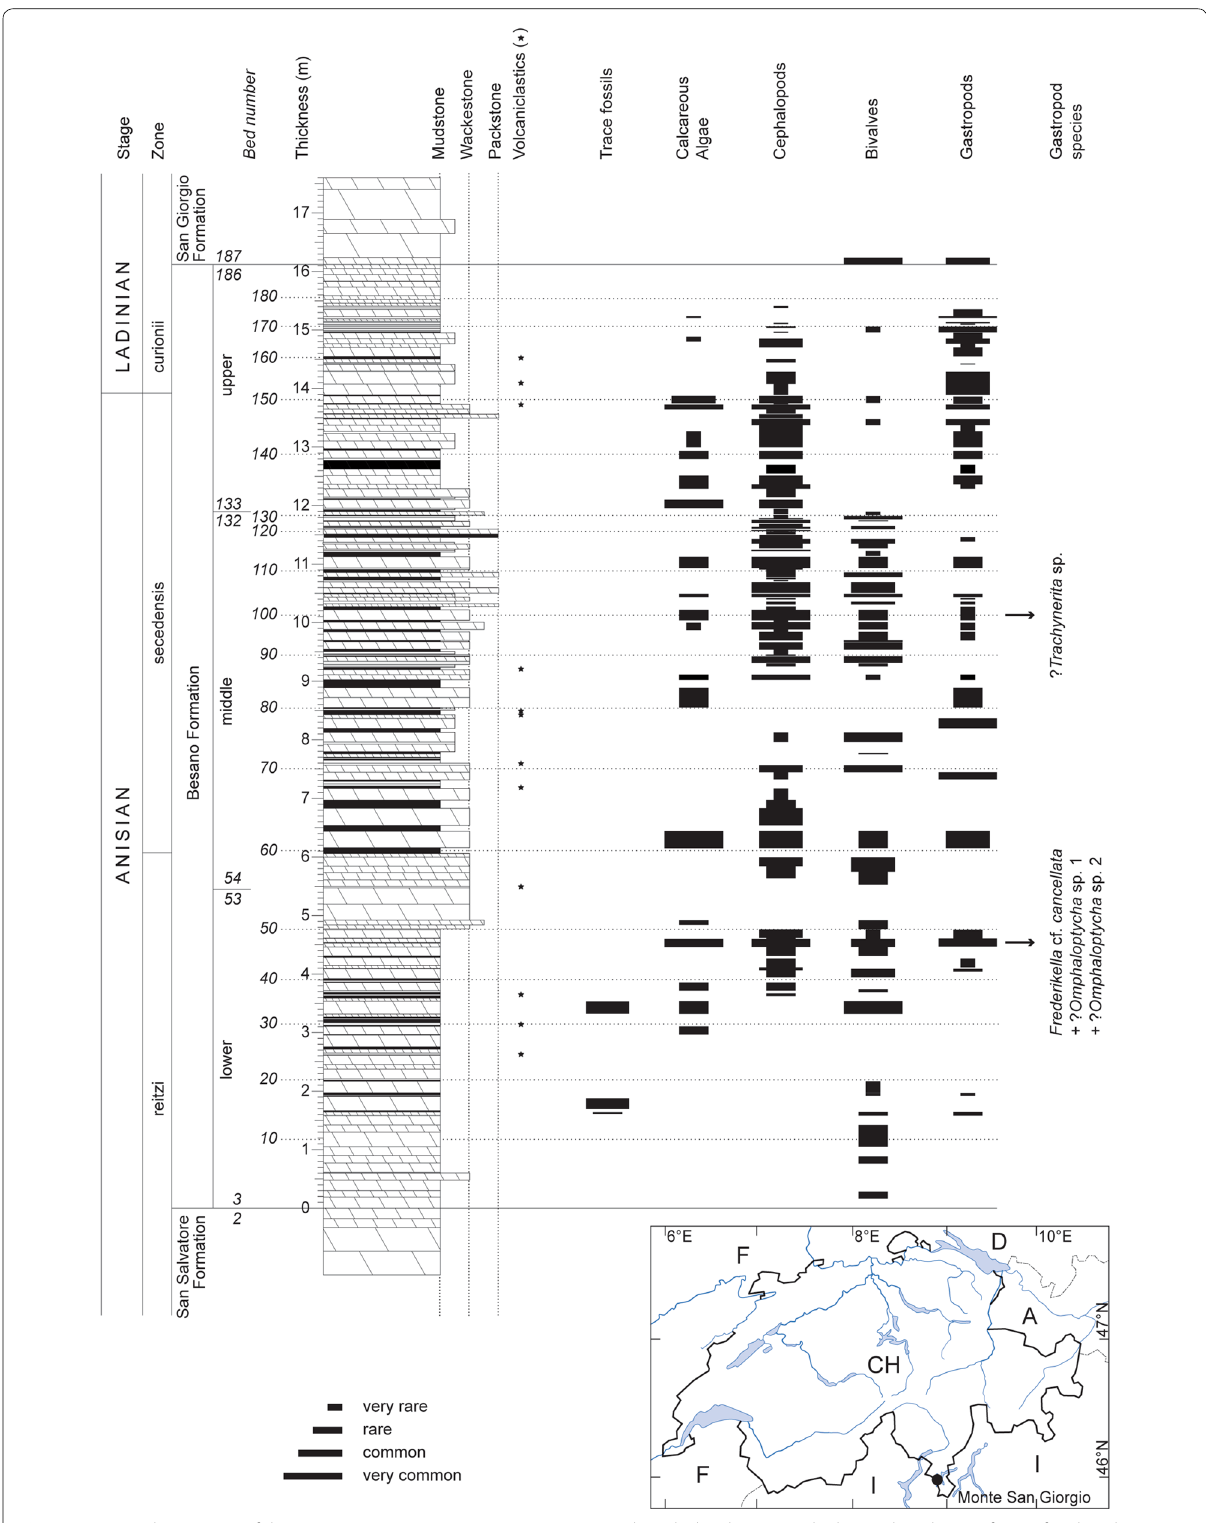
Fig. 1 Stratigraphic section of the Besano Formation at site Point 902/Mirigioli, with distribution and relative abundance of trace fossils, calcareous algae, cephalopods, bivalves and gastropods. Modified after Röhl et al. 2001 (Fig. 4), based on the internal inventory of the PIMUZ collection. The stratigraphic positions of four described specimens are